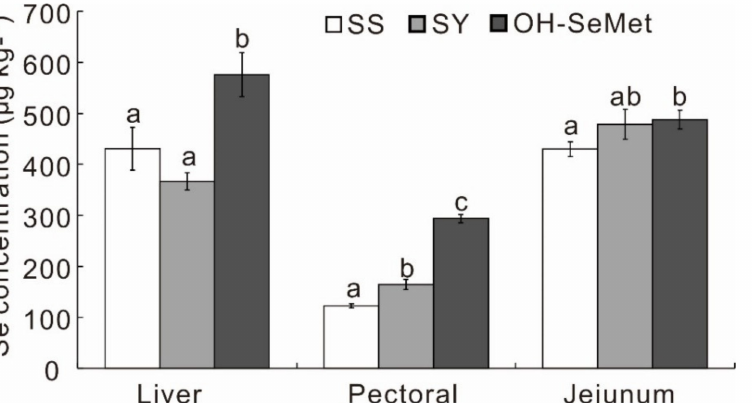
Figure 1. Effect of the three Se forms on the total Se in the fresh liver, pectoral muscle and jejunum samples of the chicks. The values are the means ± SE, n = 12. Labeled means within the same plot without a common letter differ, p < 0.05. SS, basal diet supplemented with 0.3 mg Se/kg as sodium selenite; SY, basal diet supplemented with 0.3 mg Se/kg as seleno-yeast; OH-SeMet, basal diet supplemented with 0.3 mg Se/kg as